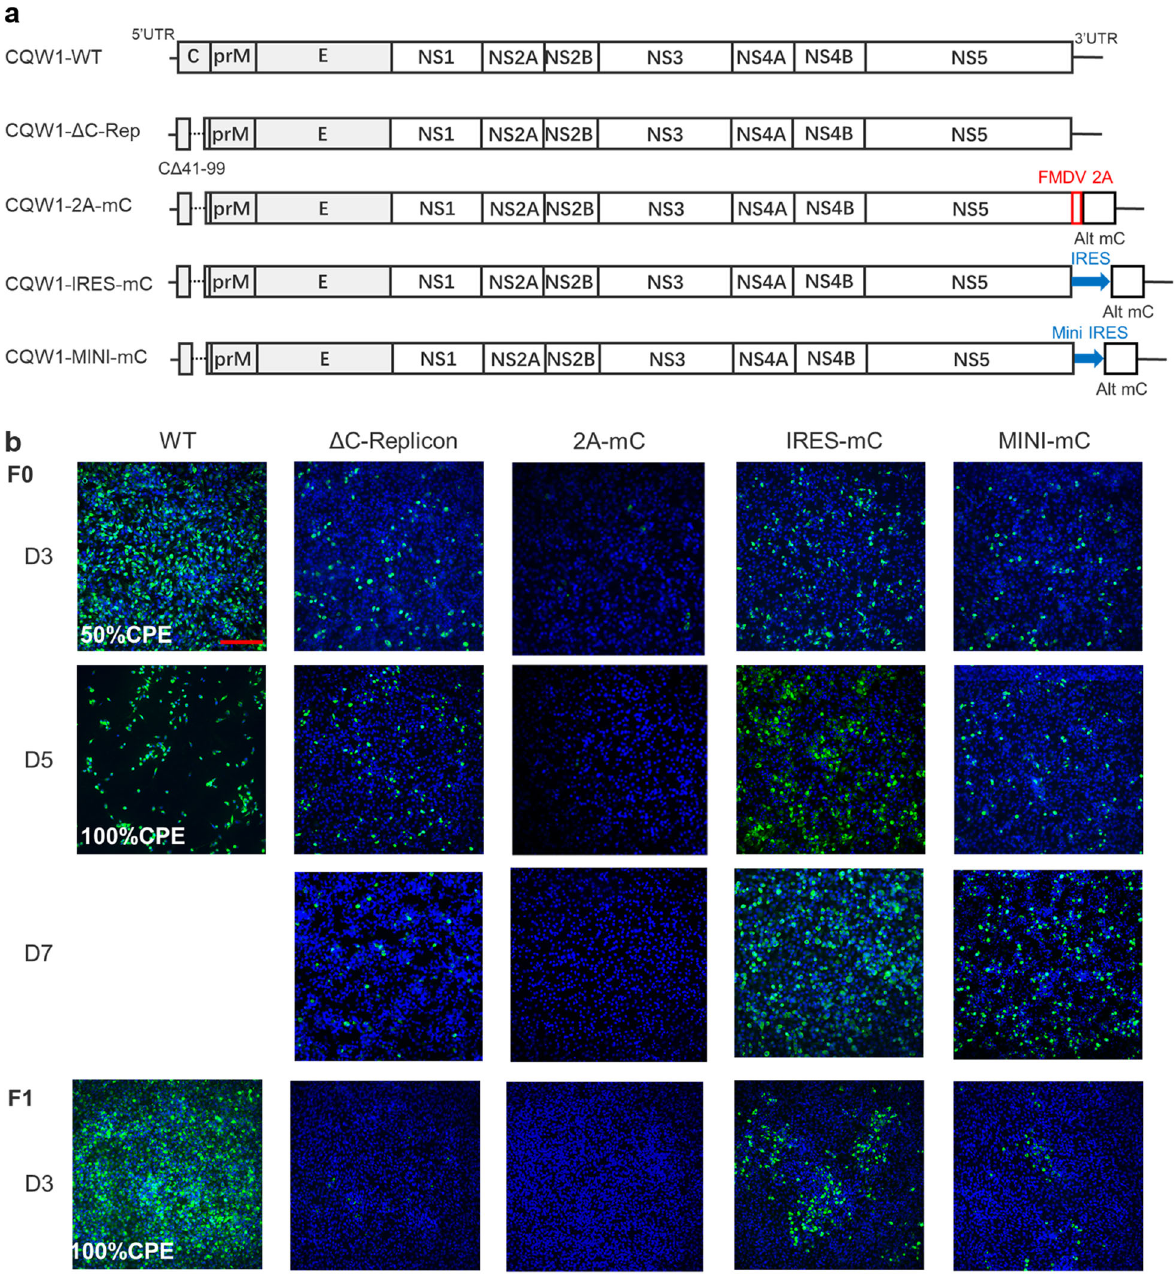
Fig. 1 Design and recovery of recombinant TMUV expressing capsid protein ectopically. a Schematic diagram for the design of the genomes of CQW1- Δ C-Replicon, CQW1-IRES-mC, CQW1-MINI-mC, and CQW1-2A-mC. b Recovery of recombinant virus determined by IFA. BHK-21 cells were transfected with in vitro transcribed RNA (F0). Five days post transfection, the supernatants were harvested for the next round of infection to generate F1 viruses. The cytopathic effect (CPE) is also presented as a percentage if clear CPE is observed. The length of the scale bar (displayed in a red line segment) represents 400 μ